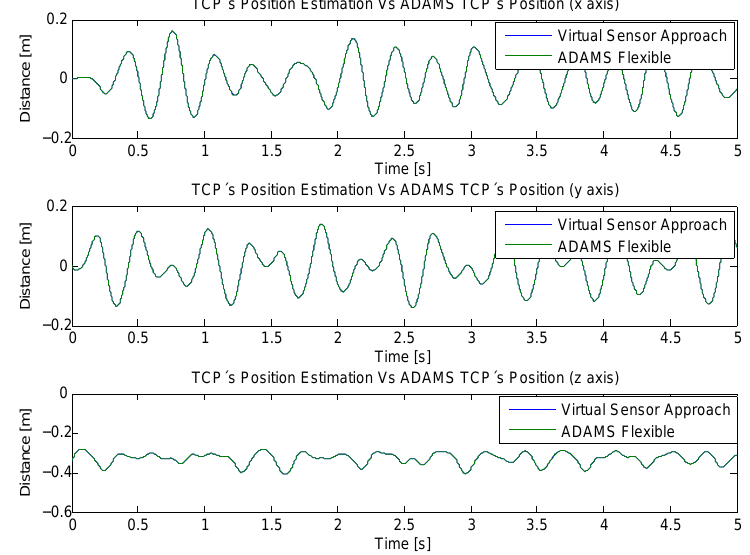
Figure 12. Virtual Sensor TCP deflection estimation compared with the TCP’s deflection obtained with ADAMS Multibody